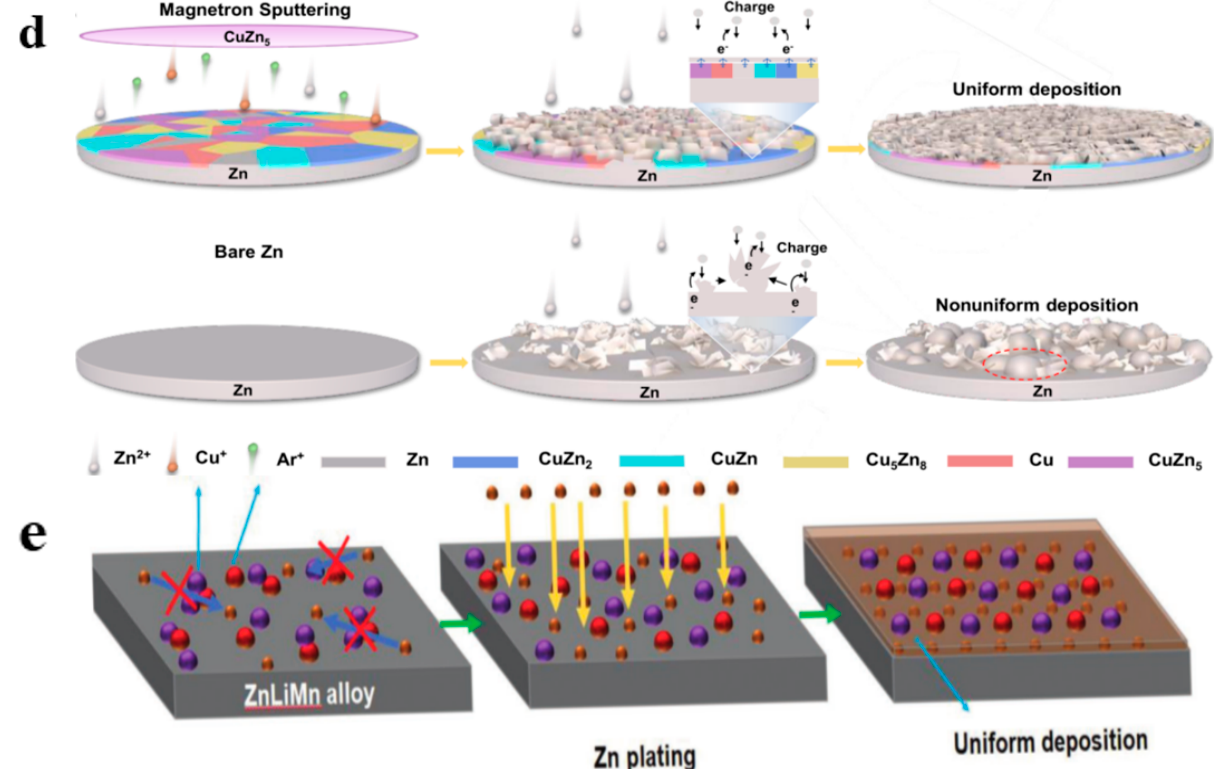
Figure 5. ( a ) Schematic diagram of zinc deposition on a Zn@ZIF-8 anode surface. Reproduced with permission [65]. Copyright 2021 ACS. ( b ) Dendrite-free GaIn@Zn anode by alloying-diffusion synergistic strategy. Reproduced with permission [67]. Copyright 2021 ACS. ( c ) 3D NP Zn-Cu alloy electrode fabrication process. Reproduced with permission [68]. Copyright 2020